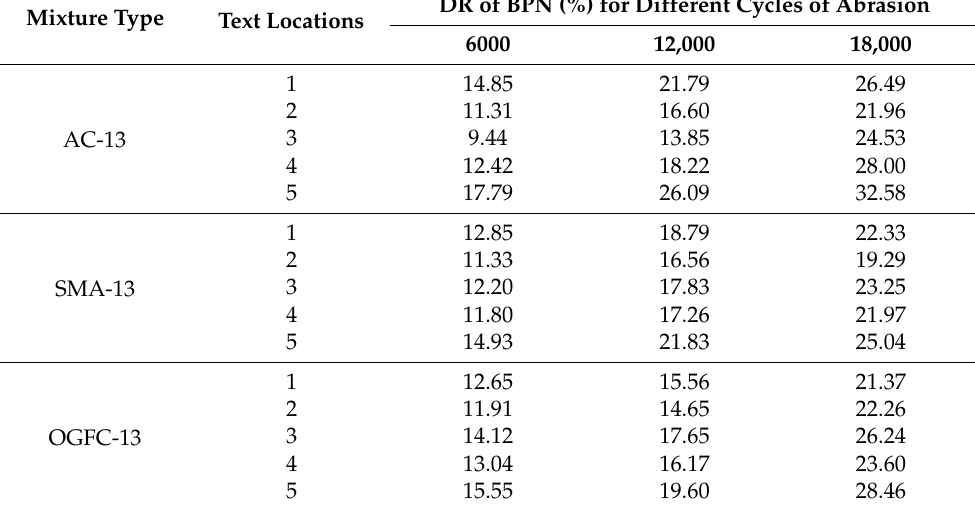
Table 7. DR in different test locations for various mixtures.